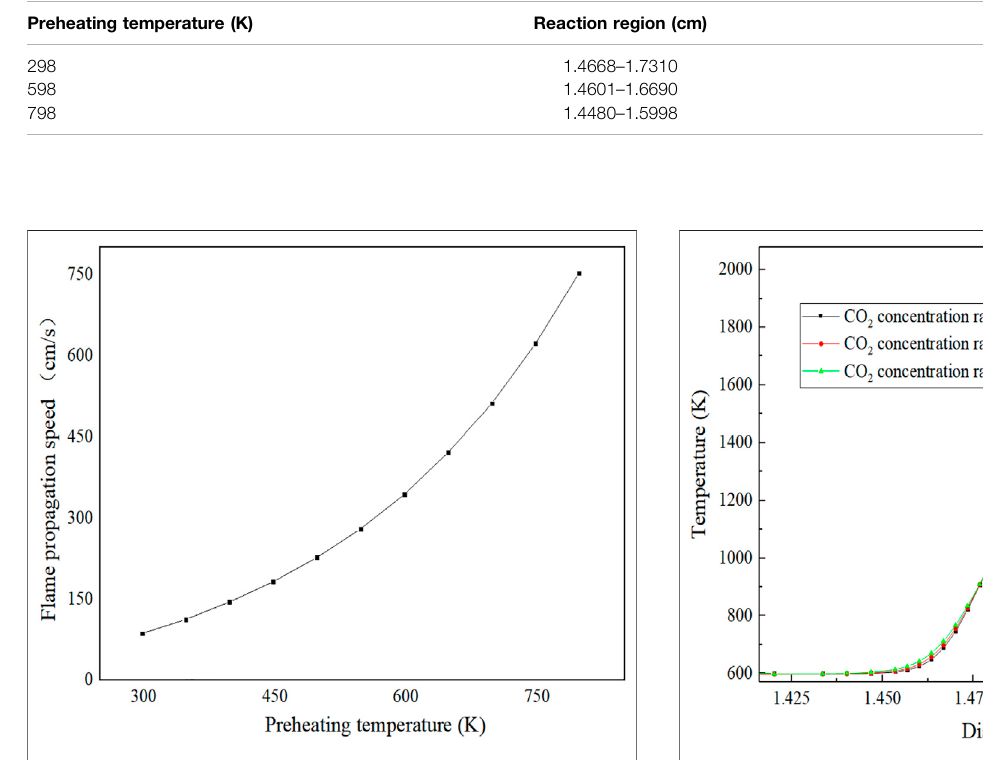
FIGURE 11 | Effect of CO 2 concentration on fl ame combustion